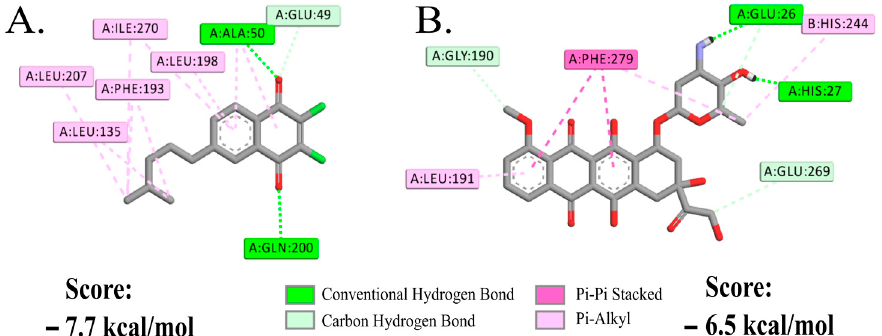
Figure 4. Interaction of NQ 4 and doxorubicin with DENV-2 prefusion envelope protein (ENV) . Interactions formed by NQ 4 ( A ) and doxorubicin ( B ) with amino acid residues reported for the hydrophobic detergent-binding pocket of the ENV protein (PDB:1OKE). Only hydrogen atoms involved in the interactions are depicted.